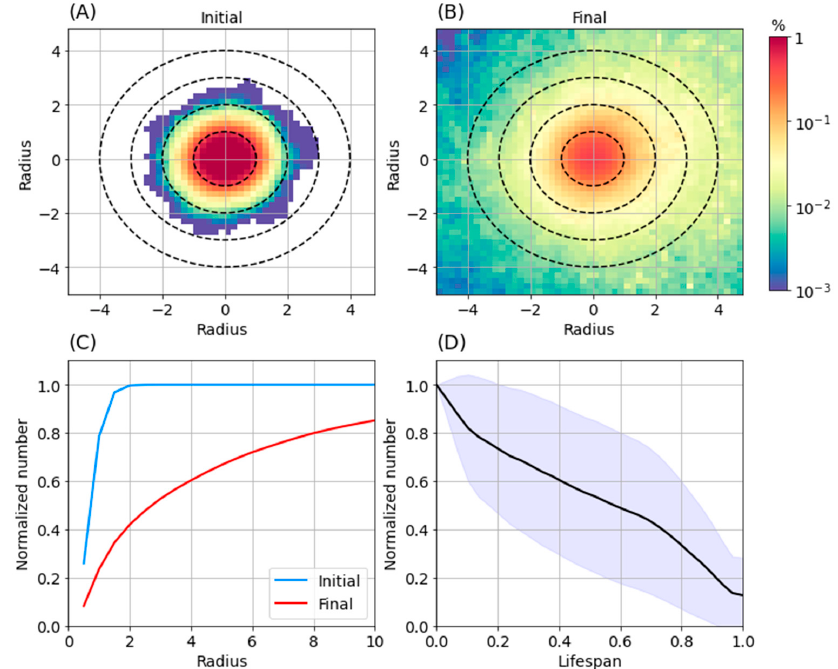
Figure 6. Statistical distributions of 𝑄 in the normalized coordinates for all eddies at the ( A ) initial and ( B ) final times. ( C ) Cumulative ratio of initial particles within a given distance normalized by eddy radius. ( D ) Leakage trend for all eddies during the normalized lifespan, with color shading representing one standard deviation of the mean over all samples.